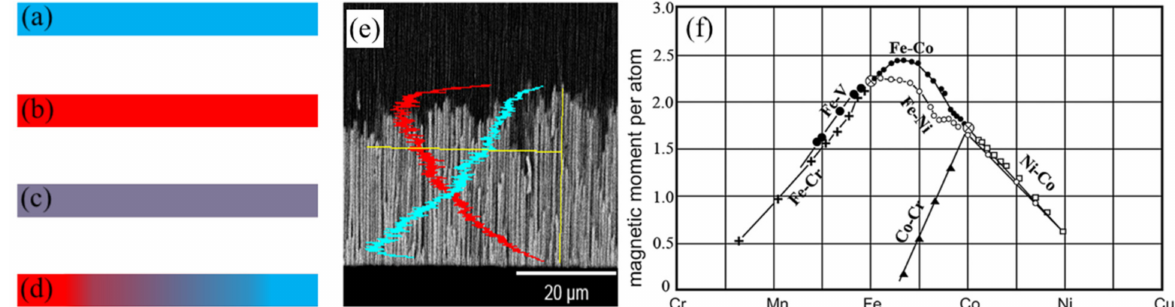
Figure 3. Demonstrating different approaches for tailoring the magnetization saturation and the coercivity of MNWs for encoding. ( a , b ) Single component MNWs; ( c ) multi-component or alloyed MNWs; ( d ) MNWs with modulated composition; ( e ) SEM image of modulated composition MNWs, adapted from [74]; and ( f ) represents a Slater–Pauling curve illustrating the dependency of the magnetic moment on the composition, adapted from